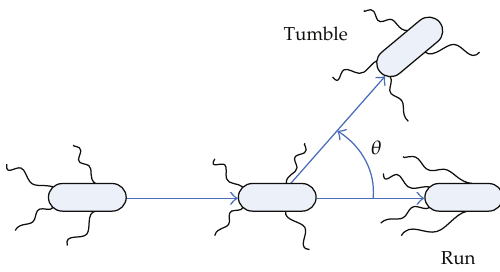
Figure 1: Chemotactic behavior of E. coli : run and